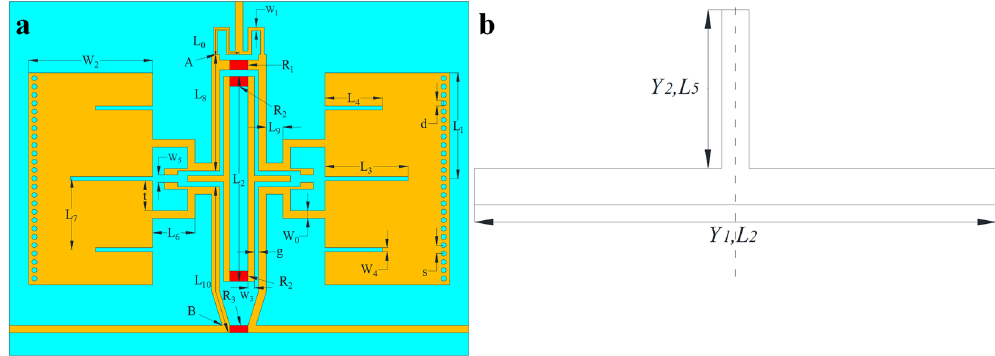
Figure 10. ( a ) Configuration of the dual-band HMSIW filtering power divider. ( b ) Dual-mode stub loaded resonator.